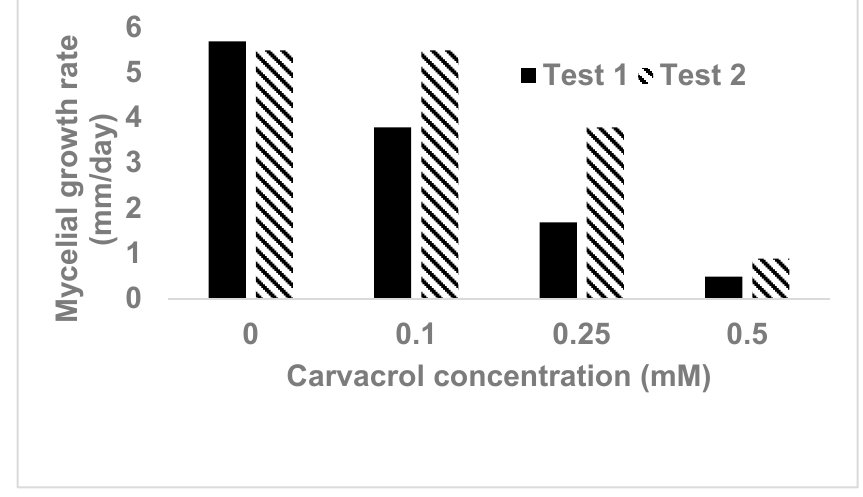
Figure 1. Effect of carvacrol on mycelial growth of Phytophthora capsici on V8 juice agar. Carvacrol was added into media right before the media was poured into Petri dishes. Test 1 was conducted with inoculating media on the same day of its preparation, whereas in the test 2 inoculation was carried on 7-day-old agar plates. No mycelial growth was observed on the plates containing carvacrol at 1.0 mM in both tests.